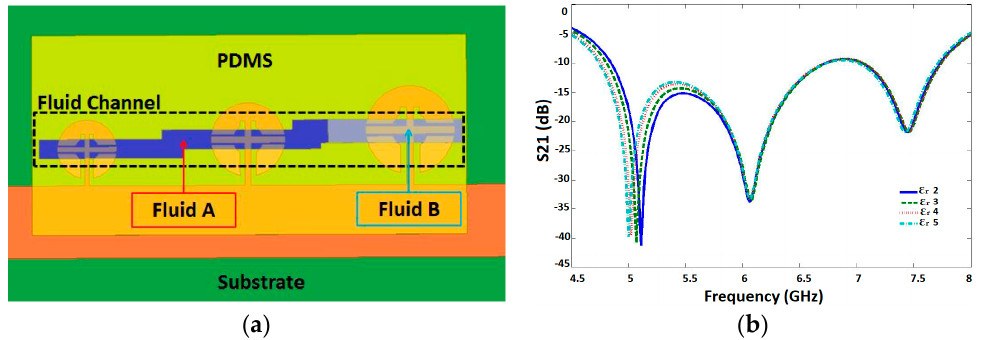
Figure 4. An OSRR coupled with microstrip line and integrated with a microfluidic channel proposed as a chemical sensor. The Spacing between OSRR elements with reference to outermost points (Dy) is optimized for all the proposed designs. ( a ) Simultaneous detection of multiple fluids, a pictorial view; and ( b ) insertion loss of the microfluidic sensor when permittivity of Fluid B was varied while keeping the permittivity of Fluid A constant (Redrawn from [37]).